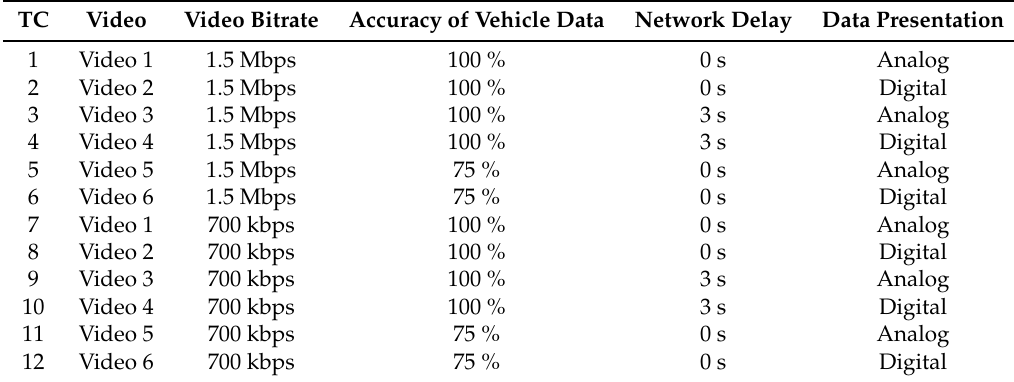
Table 1. Test Conditions